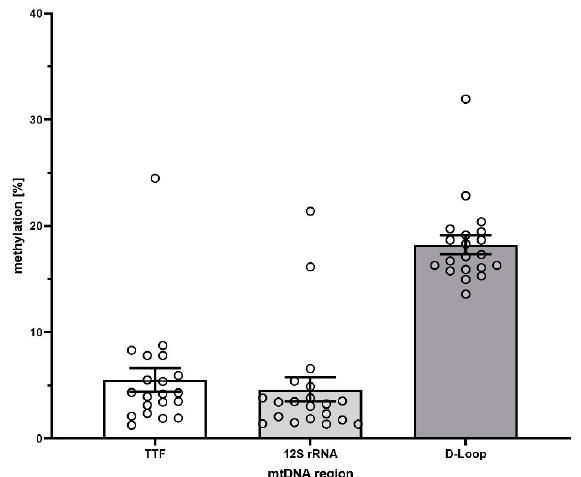
Figure 3. Methylation levels of three di ff erent regions of the mtDNA only showed the D-Loop region to be significantly